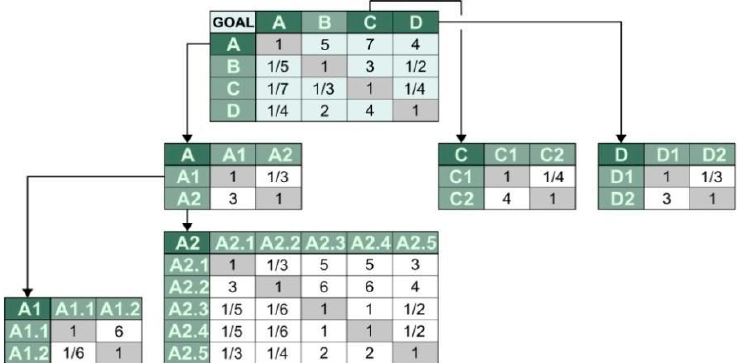
Figure 4. Matrices of ranking obtained in result of pairwise comparisons for main criteria and sub- criteria.